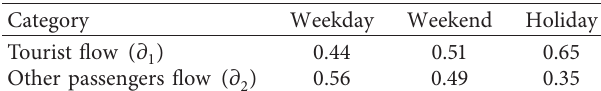
Table 6: Percentage of passenger flow at an airport with different daily characteristics.